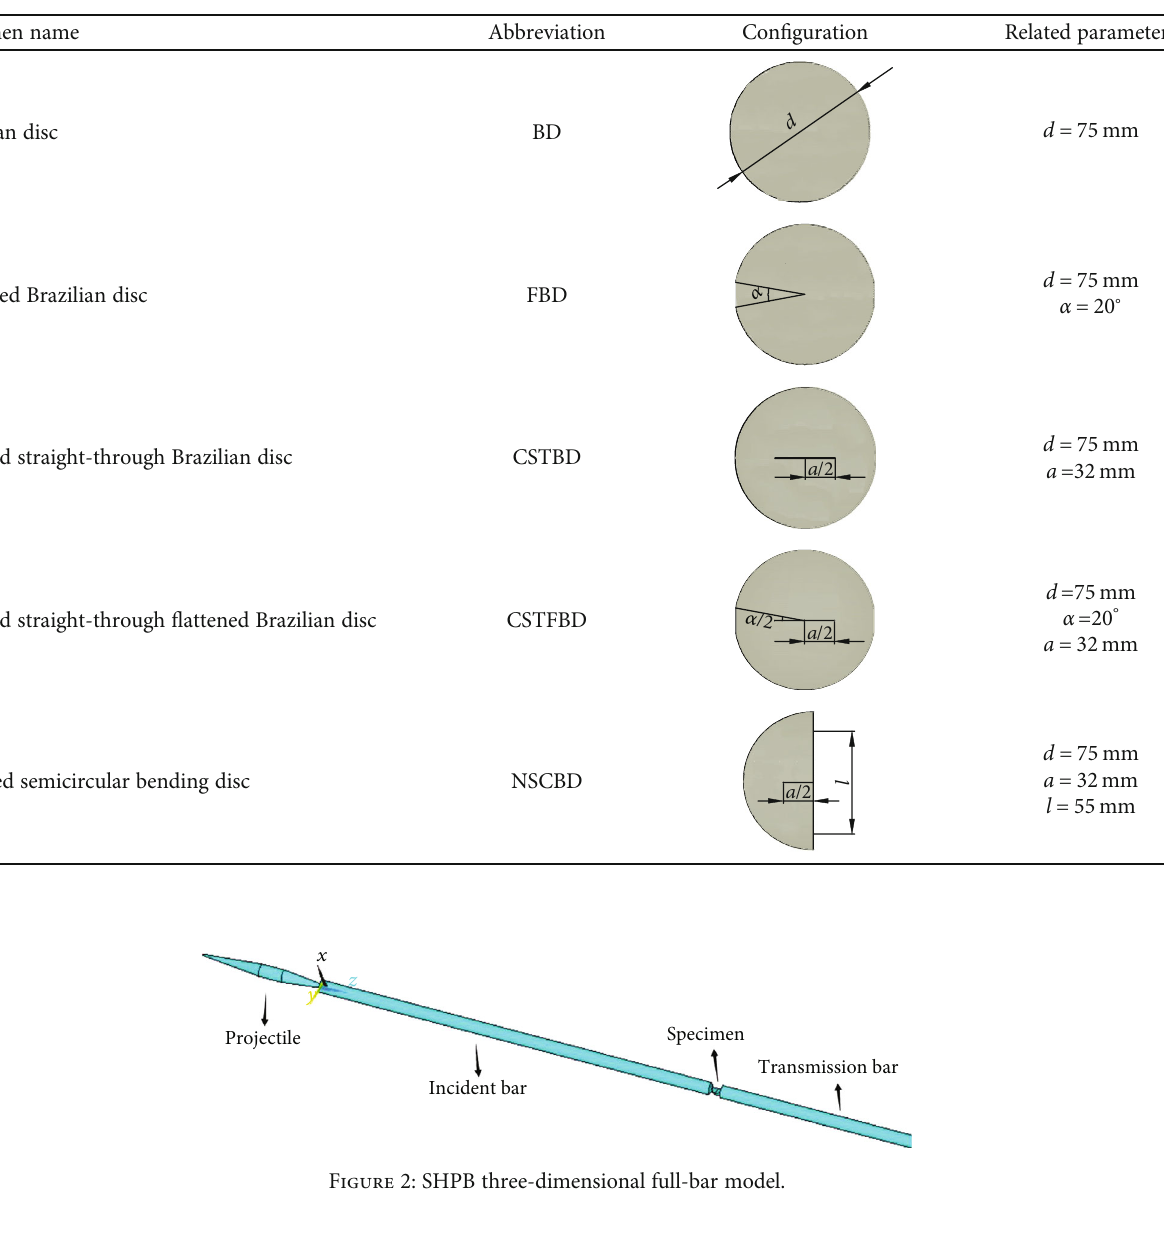
Table 1: Application of fi ve con fi guration discs.